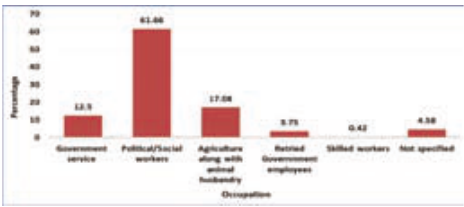
Fig. 3. Distribution of respondents based on Occupation